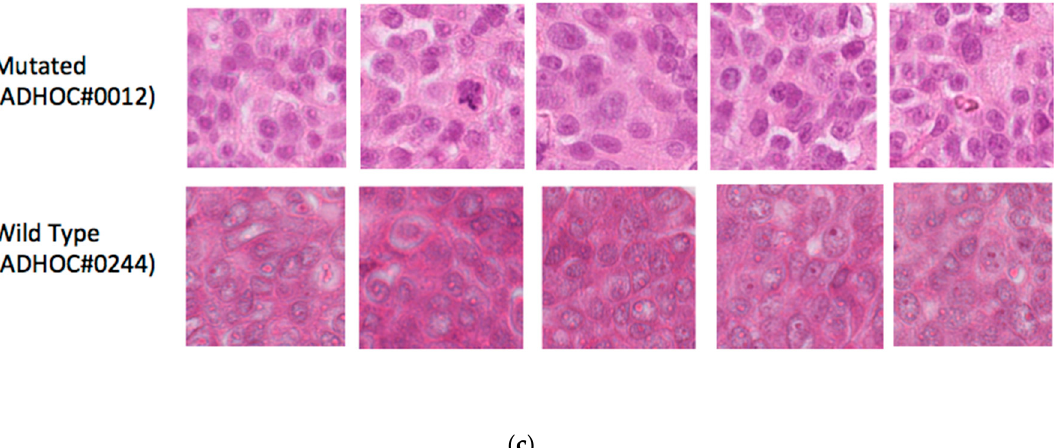
Figure 6. ( a ). Heatmap of the held-out BRCA mutated image. Red area represent areas with higher model activation, i.e., areas where the model recognizes pattern associated to the somatic BRCA mutation. ( b ). Patch level top 5 highest attention patterns (WSI). ( c ). Patch level top 5 highest attention patterns (ROI on WSI).